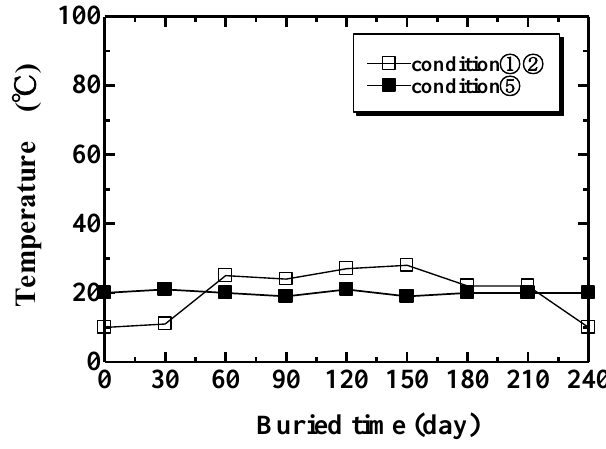
Figure 4. Temperature of natural soil (condition 1, 2) and room (condition 5).